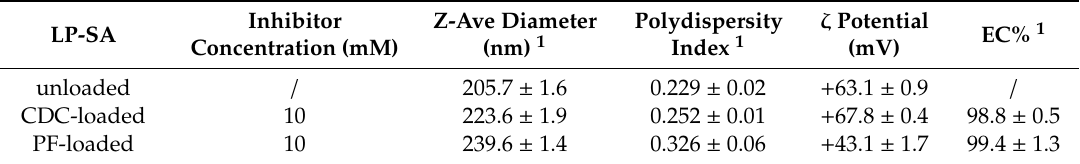
Table 3. Characteristics of LP-SA unloaded or loaded with biofilm